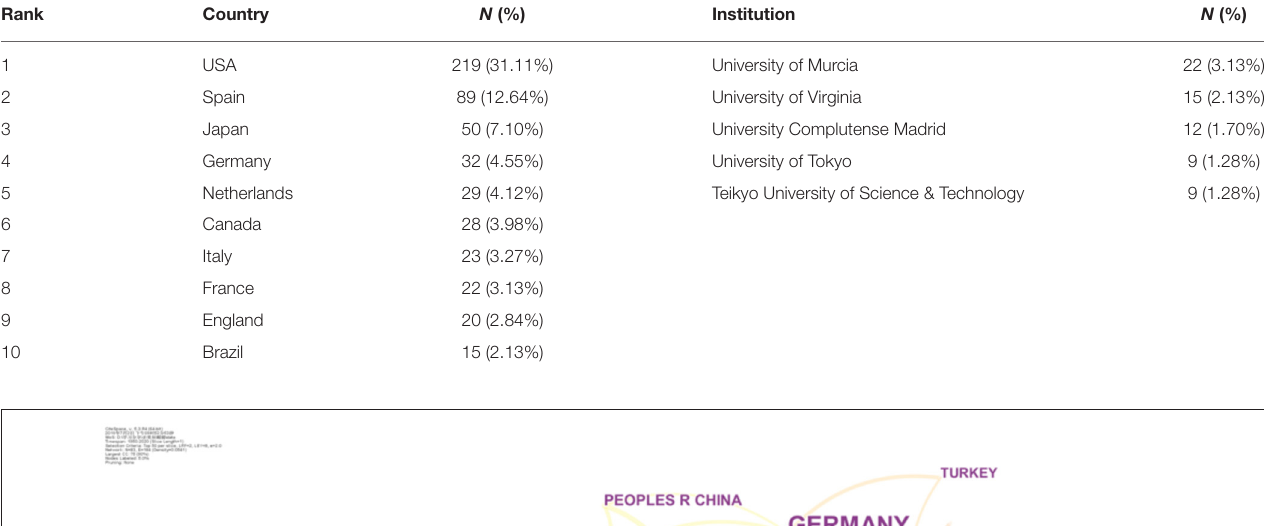
TABLE 2 | The top 10 countries and top 5 institutions of epilepsy and circadian rhythm. Rank